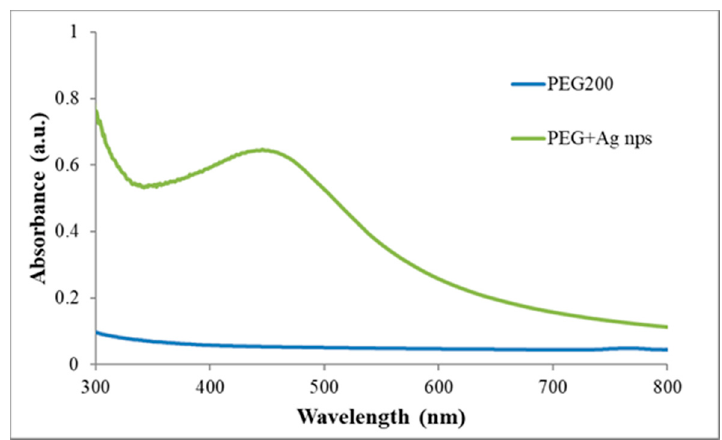
Figure 5. Absorption spectra of a PEG solution and of a solution with PEG-Ag NPs obtained using 0.1 M AgNO 3 .